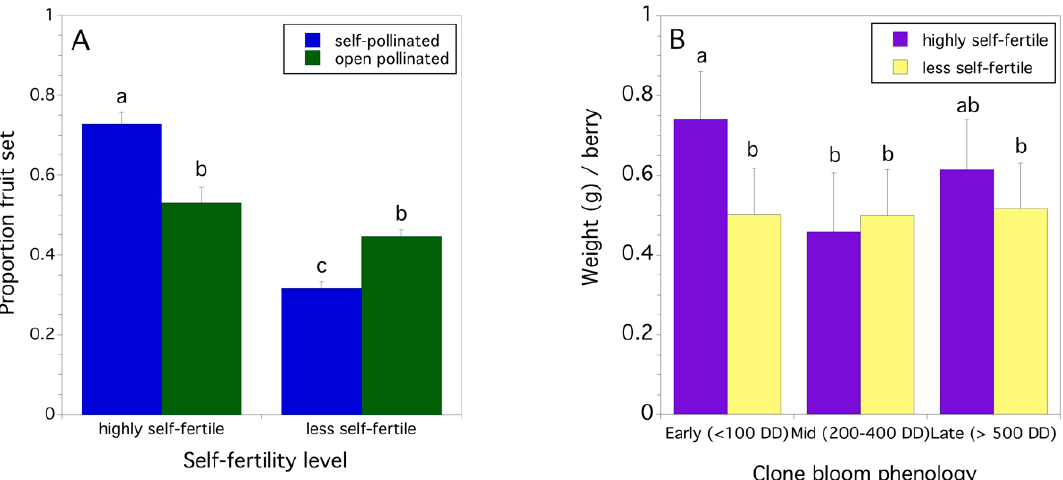
Figure 4. The effect of clones exhibiting high self-fertility interacting with pollination type (hand self-pollination vs. open pollination) on proportion fruit set ( A ) and the effect of high self-fertility interacting with bloom phenology class on berry weight ( B ). Letters associated with bloom phenology classes that are the same are not significantly di ff erent (Tukey HSD, α = 005).